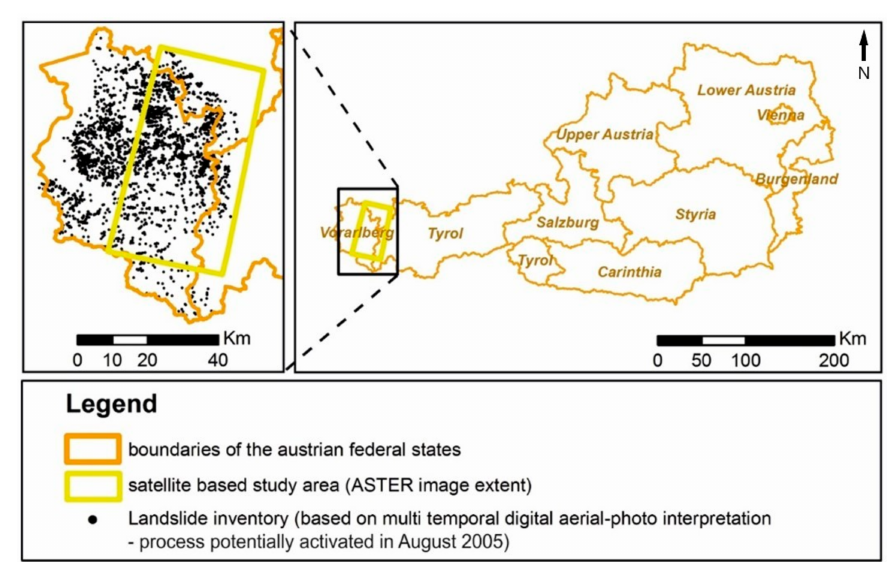
Figure 1. Study area covered by the satellite images overlaid to the landslide inventory of processes potentially activated in August 2005 (vector boundaries of Austrian Federal States© BEV).